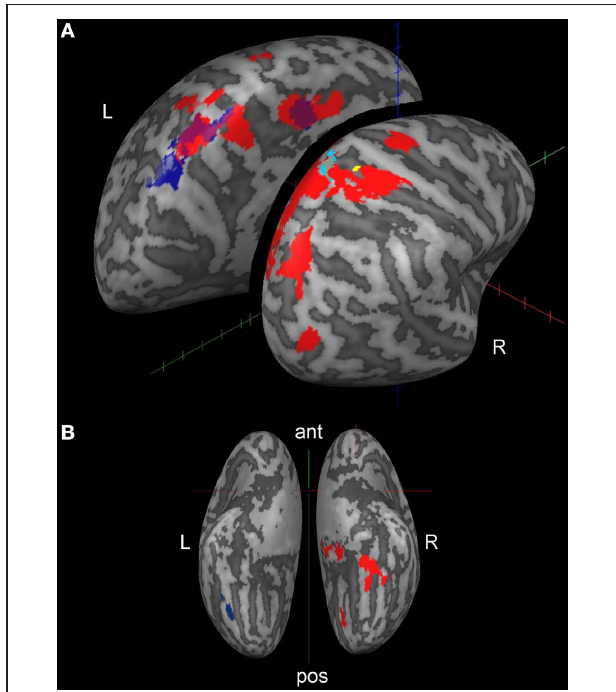
FIGURE 3 | Subcortical and hippocampal activations for the contrast SteerPv > HeadingPv (FDR, p < 0 . 05).